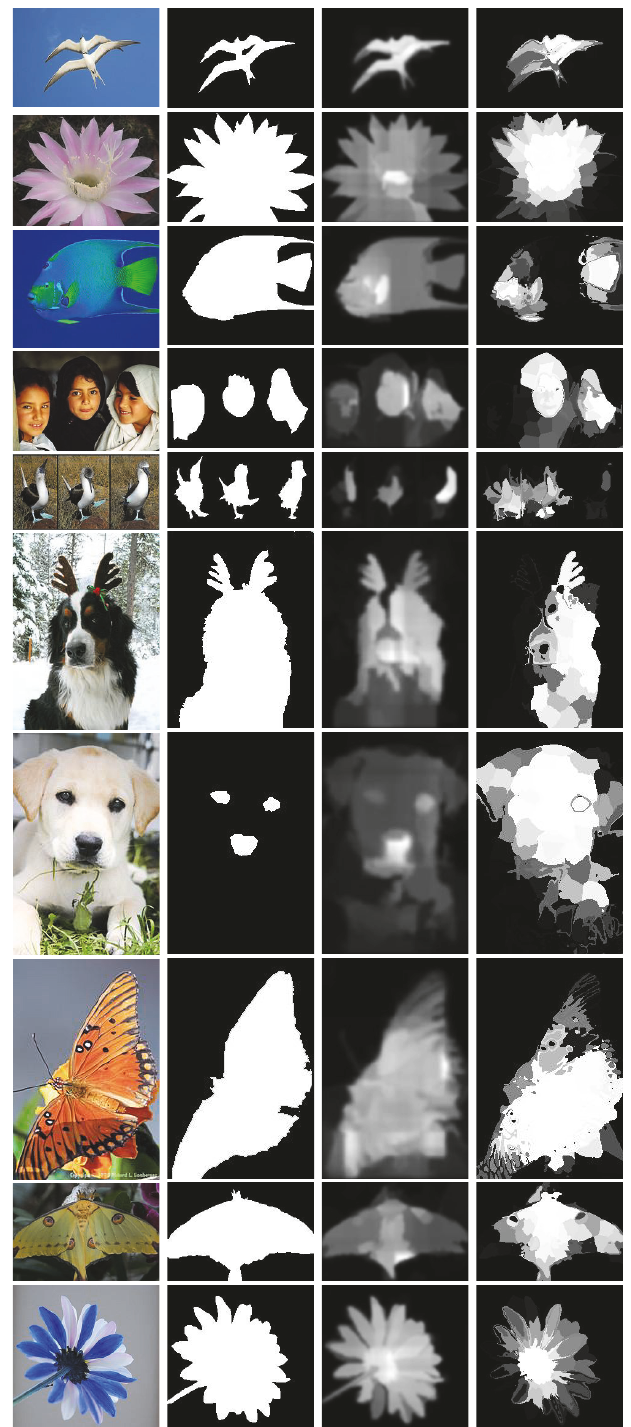
Figure 4: Examples of saliency detection results. Images in each column are original images, ground truth masks, salient maps of method DRFI [25], and salient maps of method MDF [8], respectively.